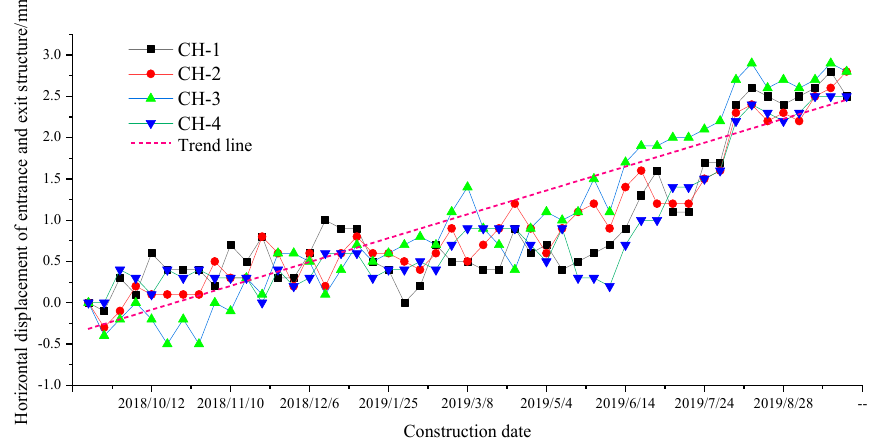
Figure 12. Horizontal displacement time − history curve of the entrance and exit structures.